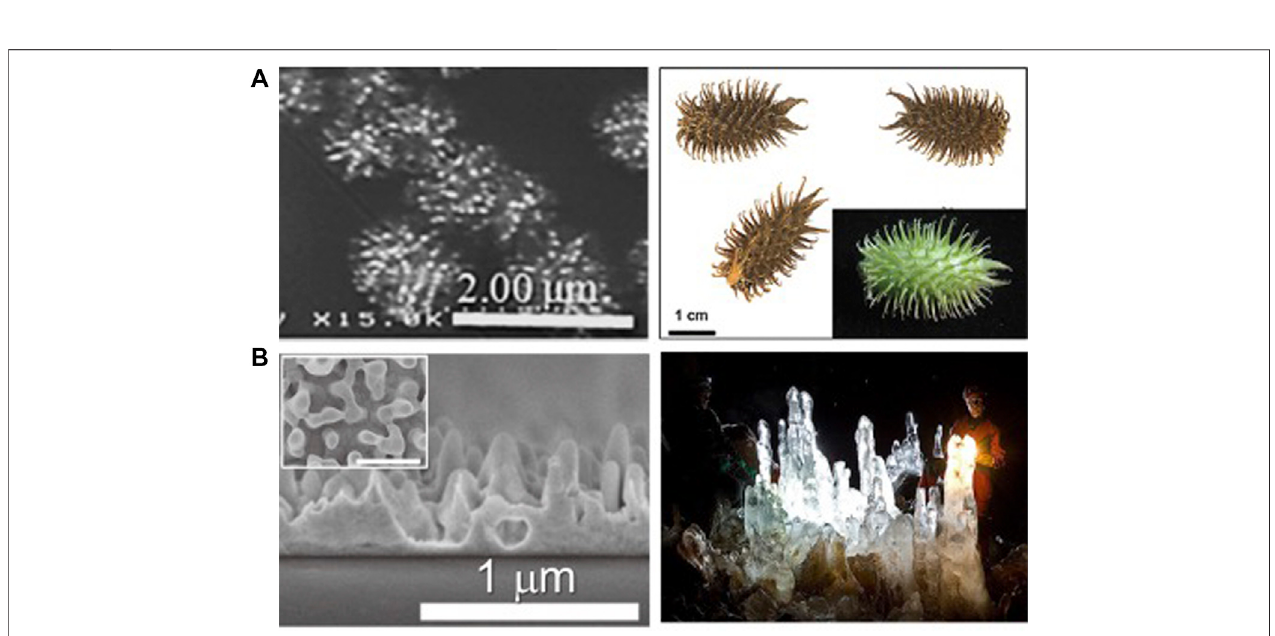
FIGURE 11 | (A) FE-SEM micrograph of the CoNi deposit after circulating − 720 mC cm − 2 of charge density on the material prepared at − 300 mC cm − 2 using a bicontinuous microemulsion as a template (13.5 wt% W, 54.5 wt% O, and 32.0 wt% S) [Reprinted from Microemulsions for obtaining nanostructures through electrodeposition method. Electrochem. Commun. 27, 14 – 18 (2013) with permission from Elsevier]. Xanthium strumarium L. This fi le is licensed under the Creative Commons Attribution-Share Alike 3.0 Unported license. Available on: https://commons.wikimedia.org/wiki/File:Xanthium_strumarium_MHNT.BOT.2004.0.213. jpg. (B) Cross-sectional FE-SEM image of the sputtered Au fi lms after Au electrodeposition in water-rich B μ E at − 0.30 V. The inset shows the top image of the same section. [Reprinted from Monolithic Au Nanoscale Films with Tunable Nanoporosity Prepared via Dynamic Soft Templating for Electrocatalytic Oxidation of